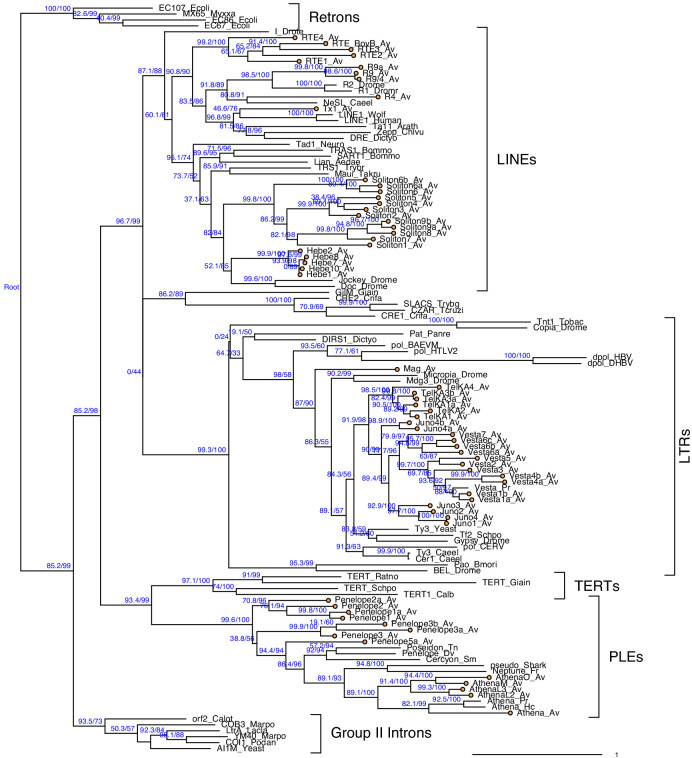
Maximum likelihood phylogeny for diverse reverse transcriptase domains from across the tree of life.Major RT clades are indicated with labels. Sequences from the bdelloid A. vaga are indicated with orange tip labels and the suffix ‘Av’ (see Arkhipova et al., 2003; Flot et al., 2013 for further details). Phylogeny is rooted on branch leading to bacterial retrons. Numbers on branches represent branching support (%) based on 1000 SH-aLRT and 5000 UFBoot samples, respectively. Scale bar indicates one amino acid substitution per site.